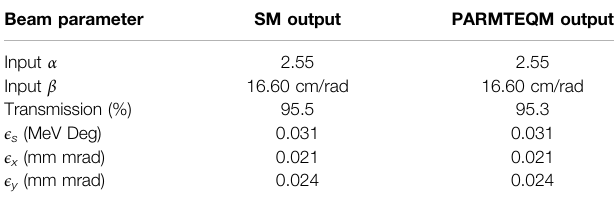
TABLE 5 | Optimum set of Twiss parameters found by Bayesian optimizer based on the surrogate model output and corresponding predicted beam output parameters with comparison to PARMTEQM results.